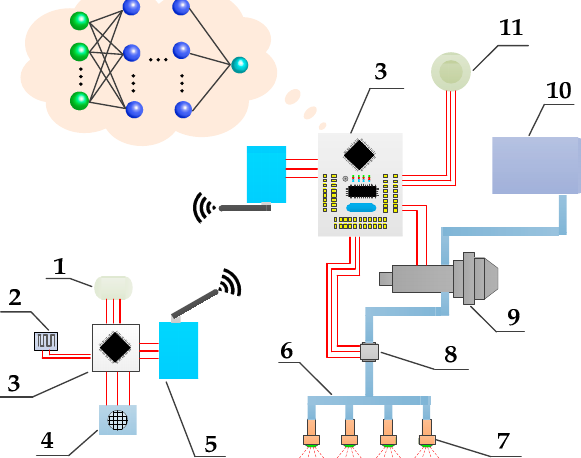
Figure 9. The structure of variable spray system based on BP neural network . Note: 1. Temperature sensor; 2. Humidity sensor; 3. STM32 control chip; 4. Wind speed sensor; 5. Wireless transmission station; 6. Compression pipe; 7. Pressure nozzle; 8. Flow sensor; 9. Micro-diaphragm pump; 10. Medicine box; 11. GPS.